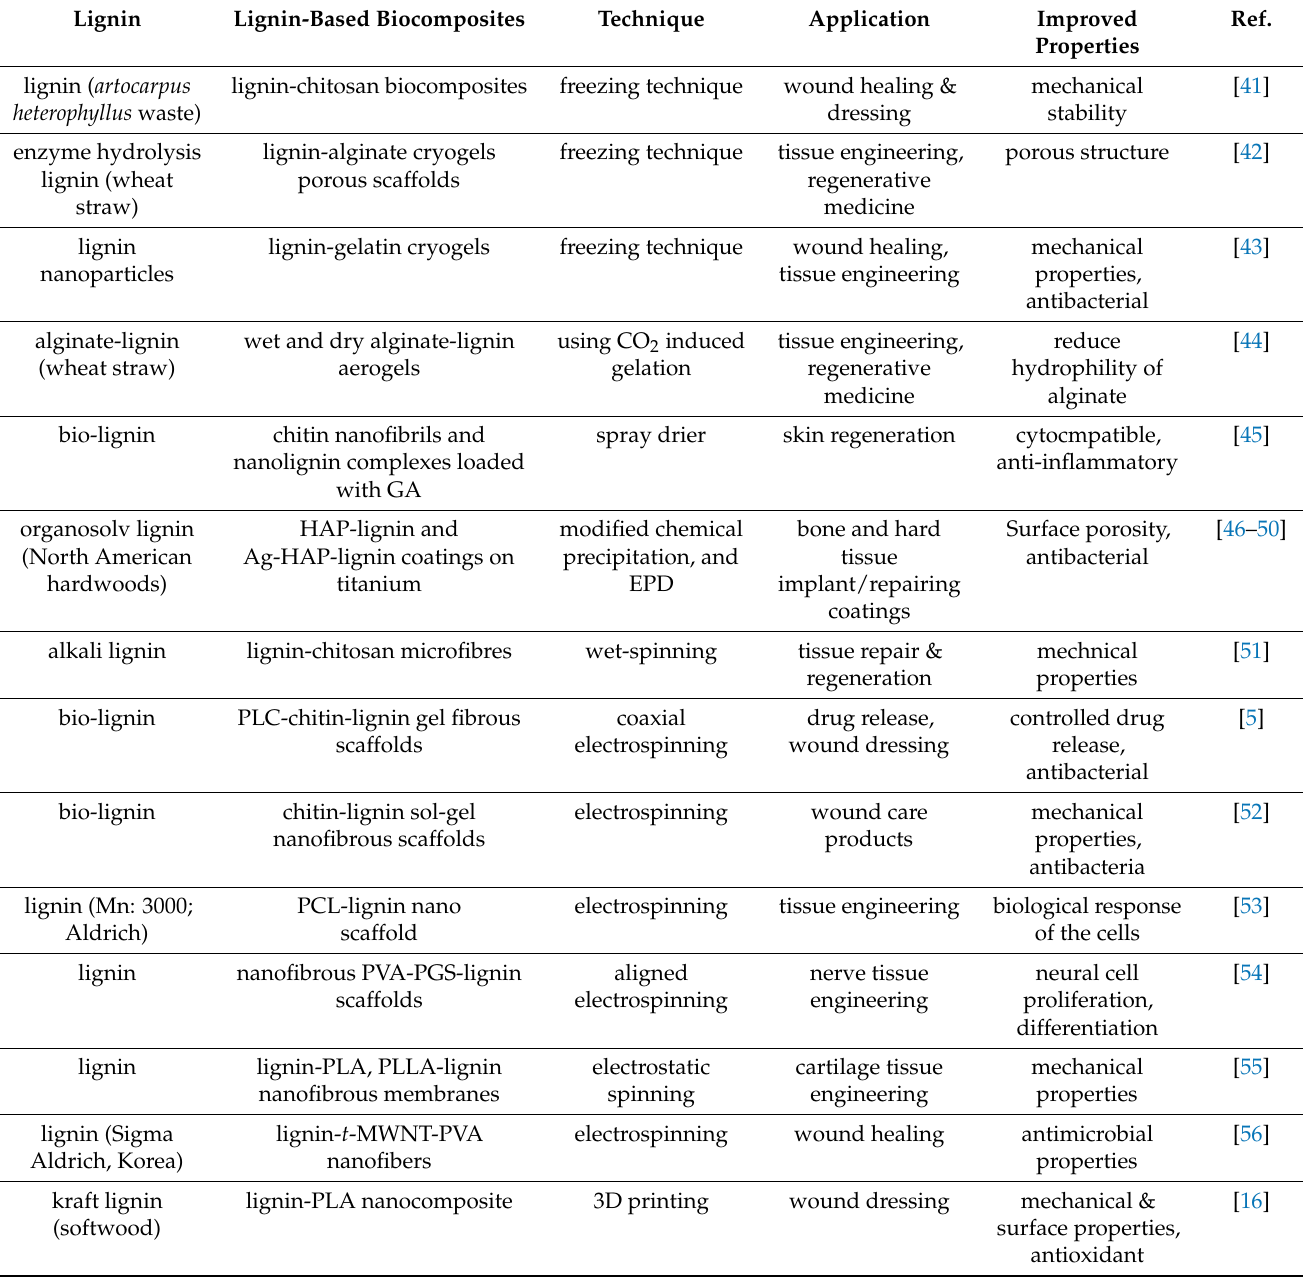
Table 3. Literature overview of lignin-based biocomposites, technologies, and